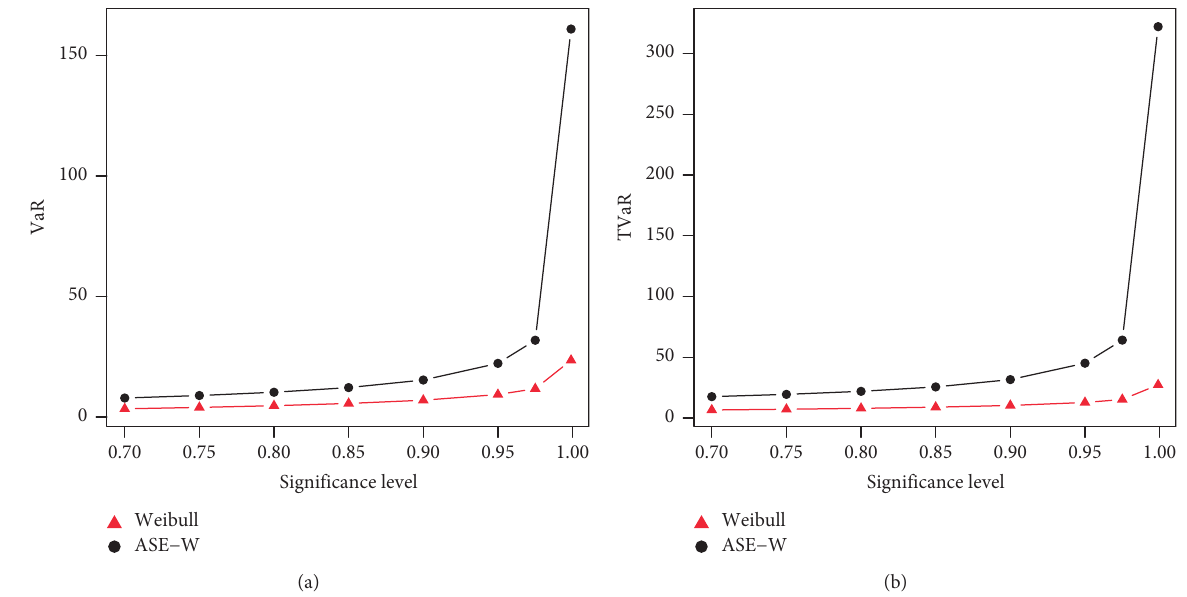
Figure 7: Graphical sketching of the VaR and TVaR using the results in Table